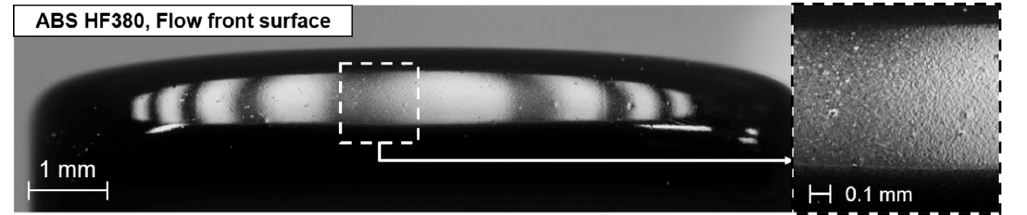
Figure 11. Rough surface at the flow front.